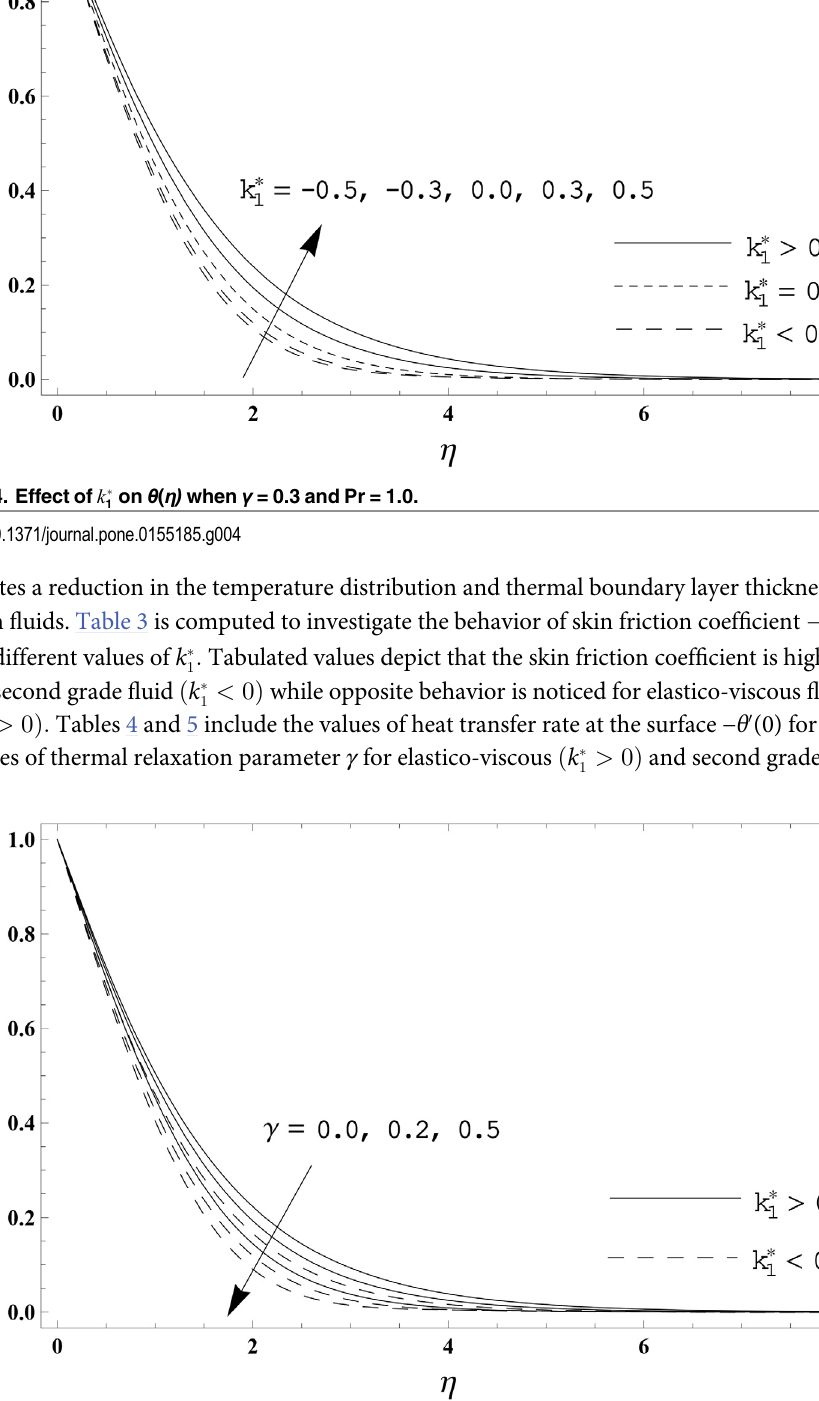
Fig 5. Effect of γ on θ ( η ) when Pr =